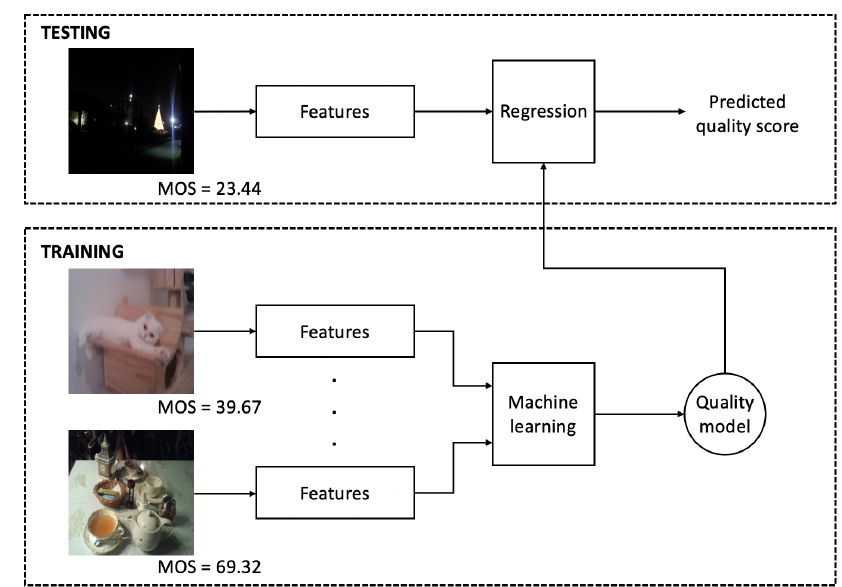
Figure 1. Block diagram of the proposed